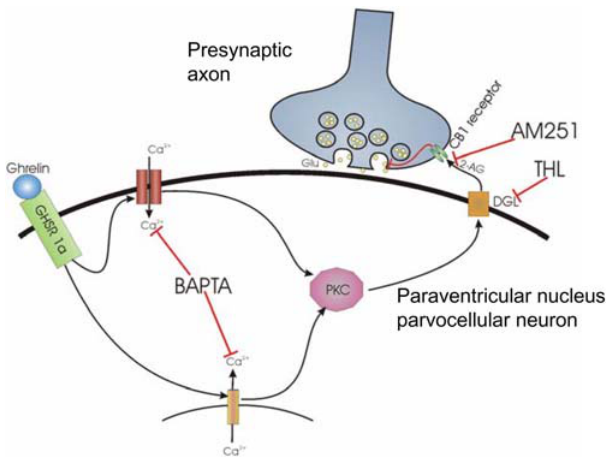
Figure 4. Schematic drawing illustrates the proposed model of ghrelin’s action in the parvocellular neurons of the PVN. Binding of ghrelin to its receptor (growth hormone secretagogue receptor 1a, GHS-R1a) on the surface of parvocellular neurons results in an increase of intracellular Ca 2 + levels due to mobilization of Ca 2 + from intracellular stores and opening Ca 2 + channels. The increased intracel- lular Ca 2 + level activates the 2-AG synthesizing enzyme diacylglycerol lipase- a (DAGL), directly or through activation of protein kinase C (PKC), resulting in an increased 2-AG synthesis and release into the extracellular space. The increased activation of presynaptic CB1 then inhibits the release of the excitatory neurotransmitter glutamate (Glu) from the axons innervating the PVN neurons. Intracellular administra- tion of the Ca 2 + -chelator BAPTA blocks this cascade by preventing the increase of intracellular Ca 2 + level, whereas extracellularly-given THL blocks the 2-AG synthesis and AM251 blocks the cascade at the level of